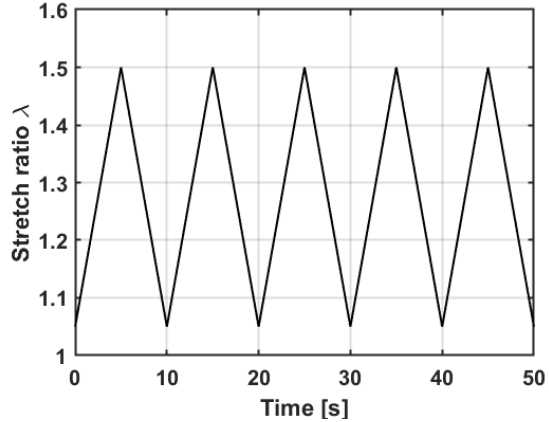
Figure 4. Specified stretch over time curve used for tests in this work: ε = 5–50% and the measuring frequency f = 0.1 Hz.